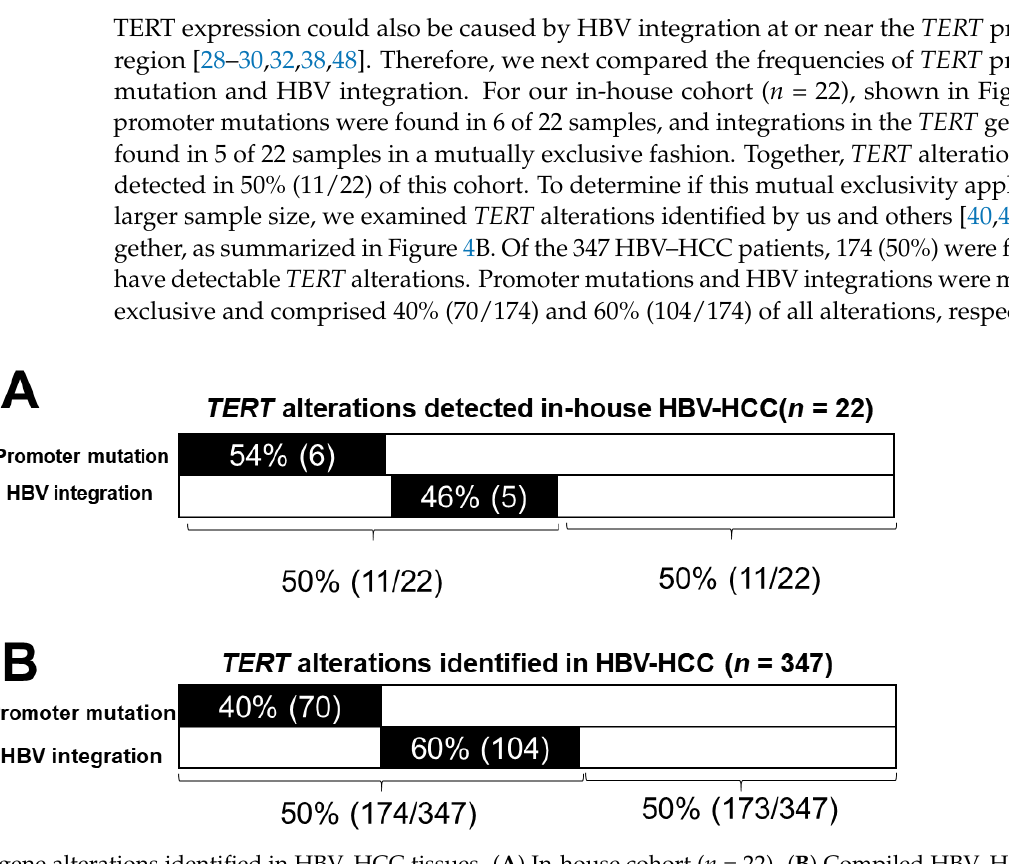
Figure 4. TERT gene alterations identified in HBV–HCC tissues. ( A ) In-house cohort ( n = 22). ( B ) Compiled HBV–HCC cohort. Patients are derived from our in-house study ( n = 22) and from the literature ( n = 129) [40,42,45]. The number of HCC patients is indicated in parentheses.